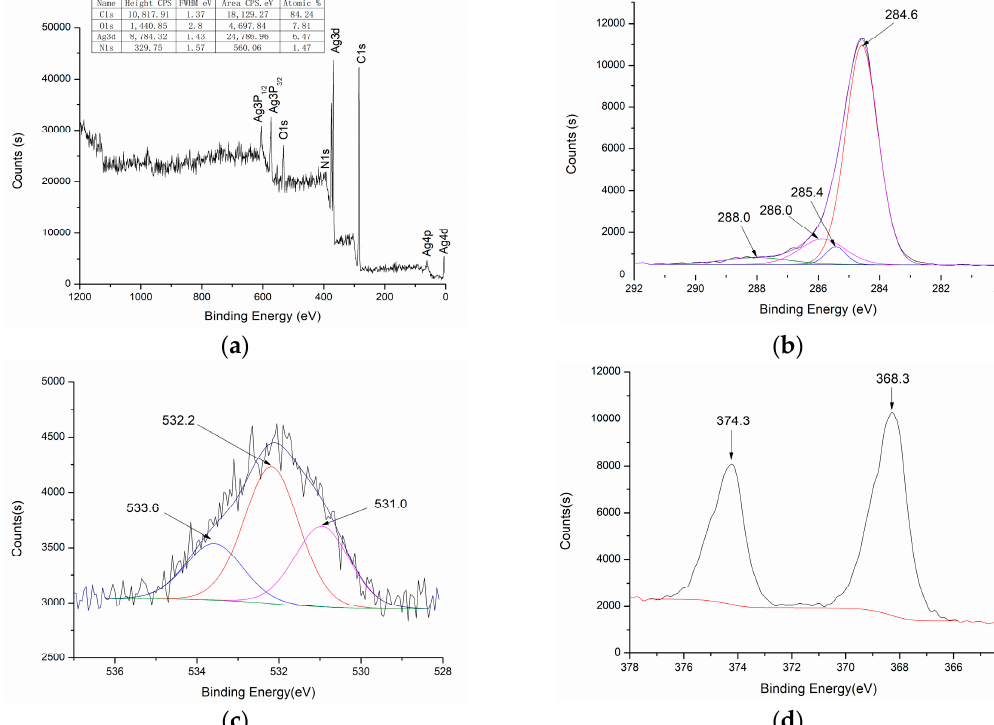
Figure 5. X-ray photoelectron spectroscopy of Ag coated nonwoven polypropylene (1#): ( a ) full spectrum, ( b ) C1s peak, ( c ) O1s peak, and ( d ) Ag3d peak.